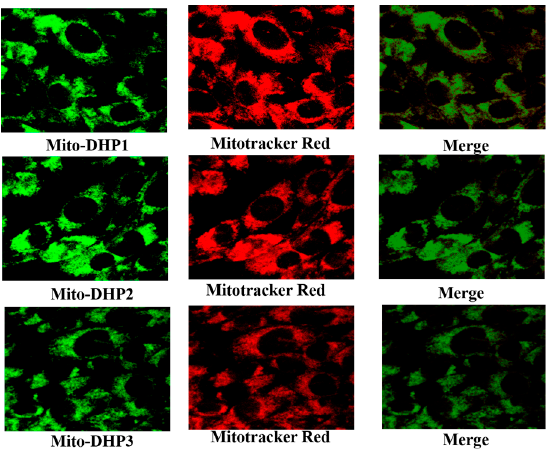
Figure 1. Accumulation of Mito-DHPs in the mitochondria of CHO-K1 cells. Fluorescence images of cells incubated with 10 − 6 mol/L Mito-DHPs for 2 h and stained with Mitotracker Red (200 nM, 15 min). Merged images show co-localization of Mito-DHP and Mitotracker Red which suggested their successful targeting to mitochondria.